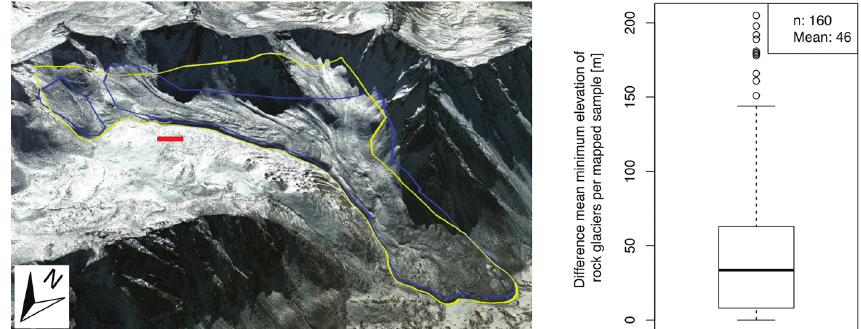
Figure 4. Example of differences between two mappings on the left (red line = 100m). Image © 2014 DigitalGlobe. For the box plot on the right only samples where both analysts have mapped rock glaciers were taken into account. The samples with big differences typically have only few rock glaciers; therefore if one object got mapped by only one analyst the mean minimum elevation could change significantly.